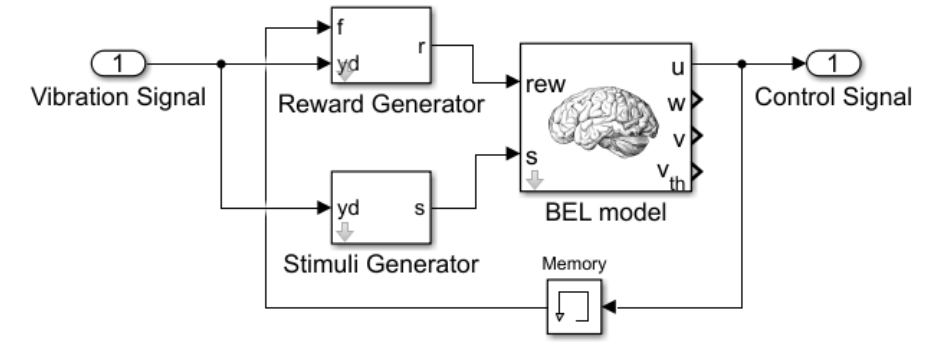
Figure 4. The BEL-based control architecture used in this